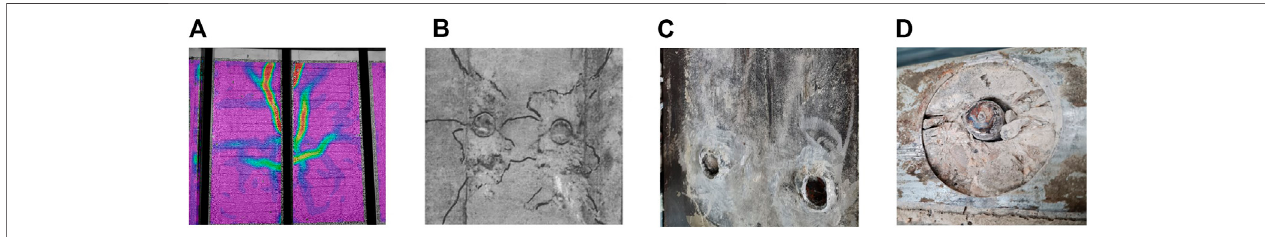
Frontiers in Built Environment |